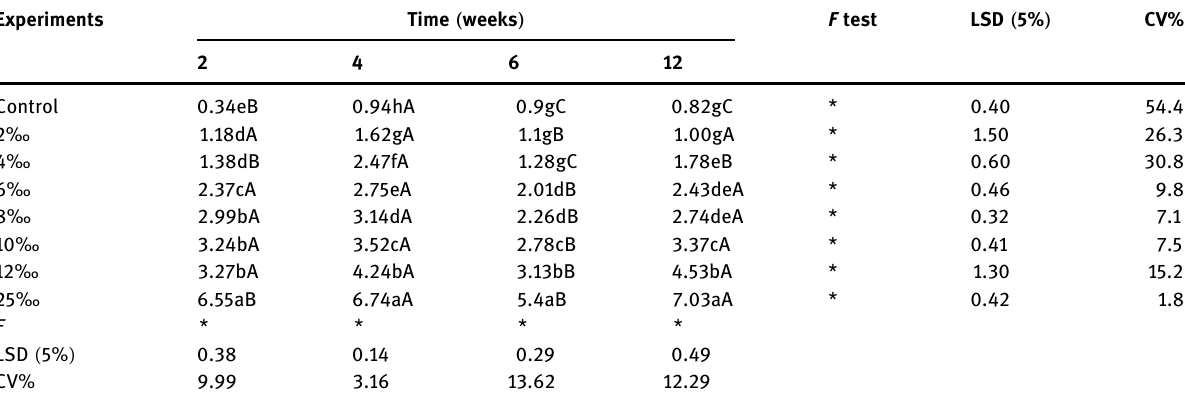
Table 7: E ff ect of salt concentration and treatment duration on exchangeable Na ( cmol/kg ) in soil